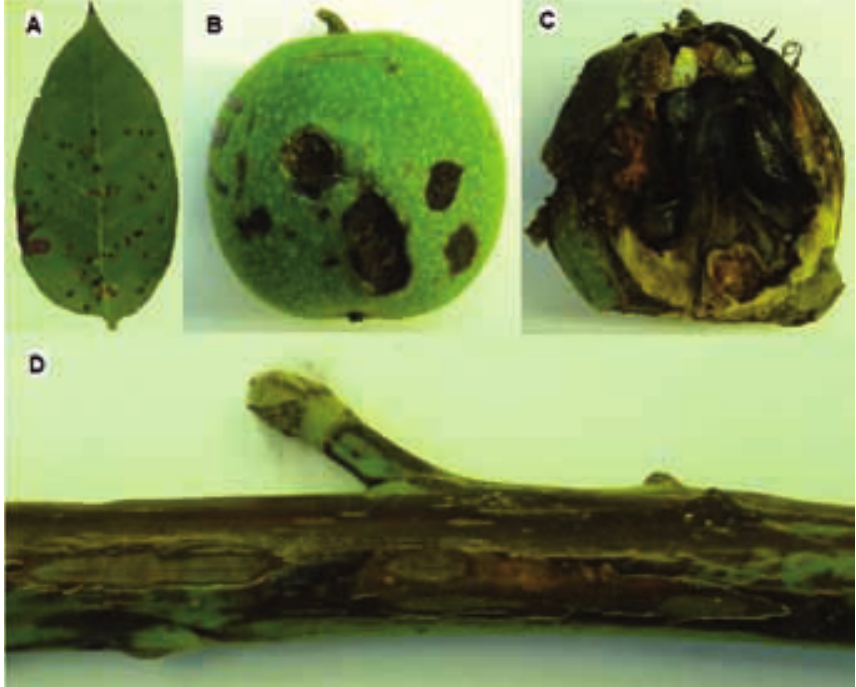
Figure 1. Bacterial blight symptoms on walnut leaves, immature fruits, kernels and young